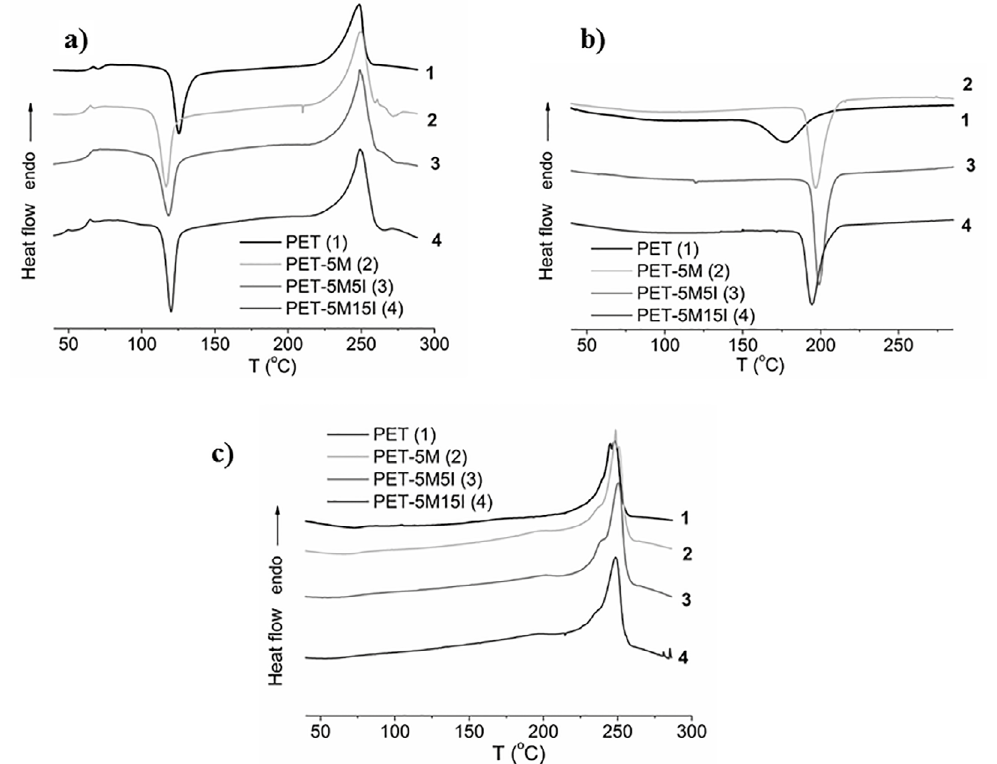
Figure 2. DSC thermograms for the PET and PET/o-Mt nanocomposites containing 5 wt% of organoclay. (a) 1 st heating, (b) cooling and (c) 2 nd heating.